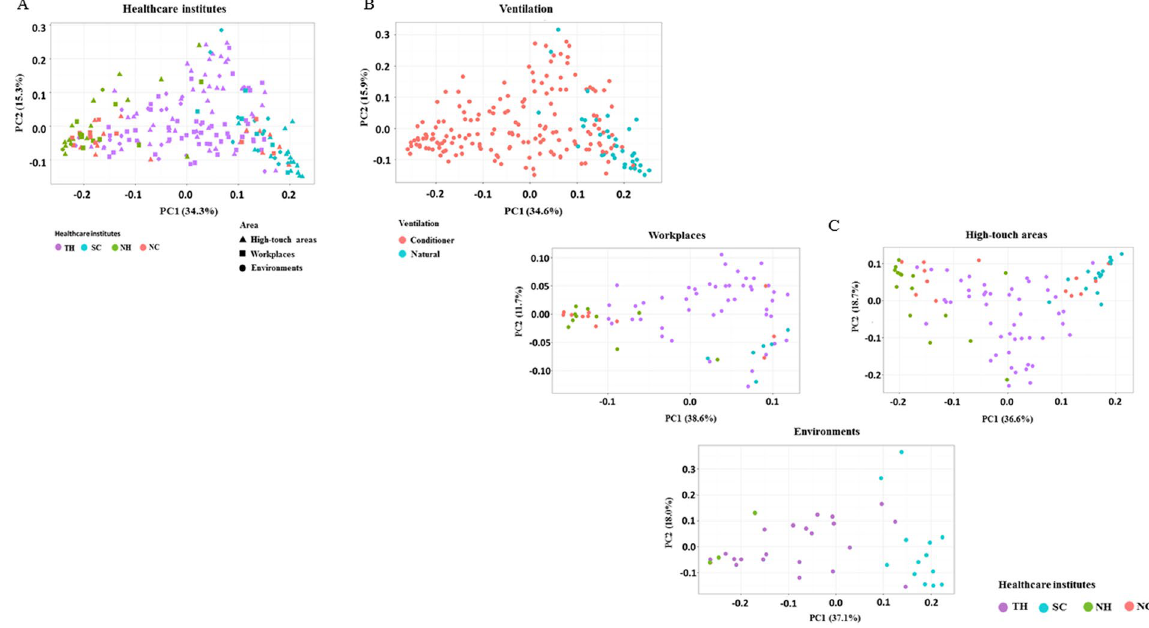
Figure 4. Bacterial communities associated with different areas among the four HCIs ( A ), different ventilation types ( B ), and workplaces, high-touch areas, and environments ( C ) by principal coordinate analysis (PCoA). PCoA plot based on the weighted UniFrac distance matrix. The percentage of diversity distribution explained by each axis is indicated in the